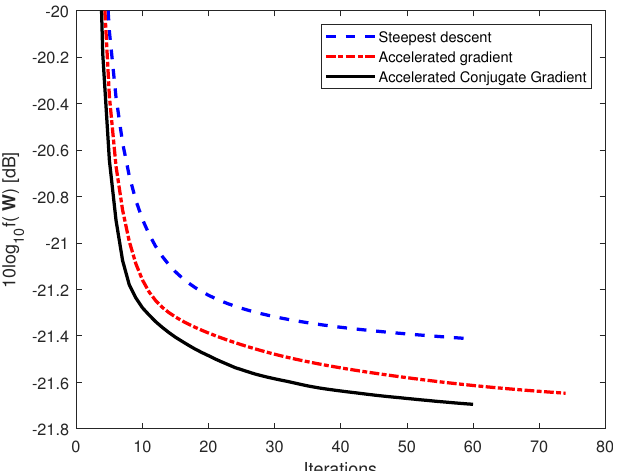
Figure 3. Convergence for simulated room recording data with three microphones and 10dB